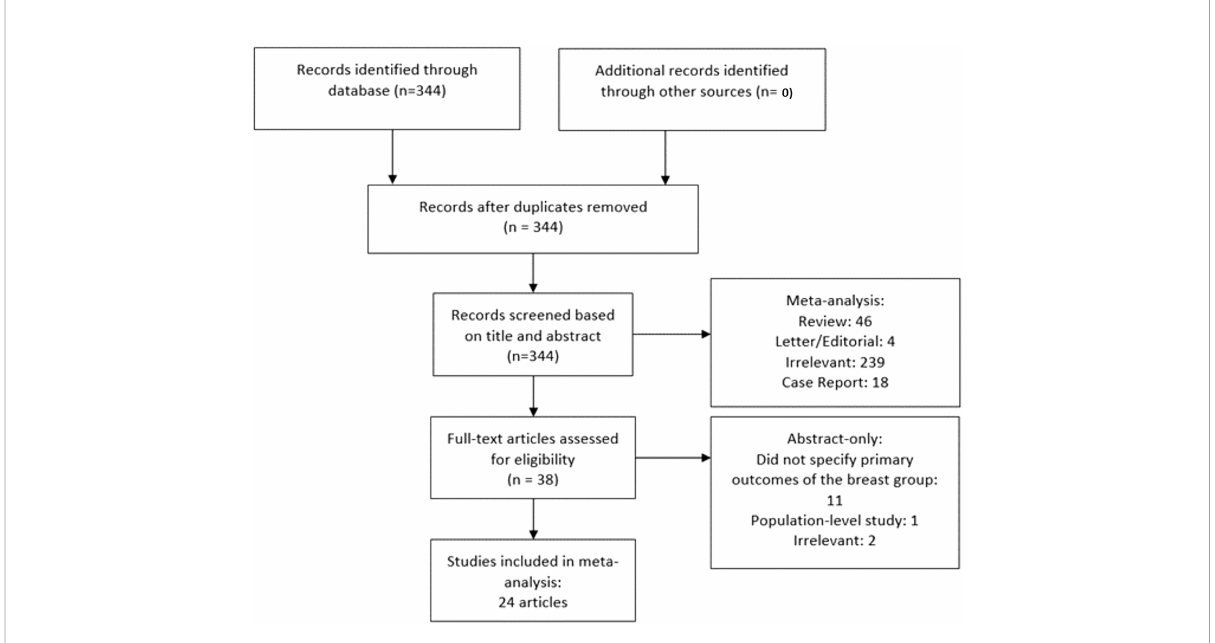
FIGURE 1 Flow diagram of literature